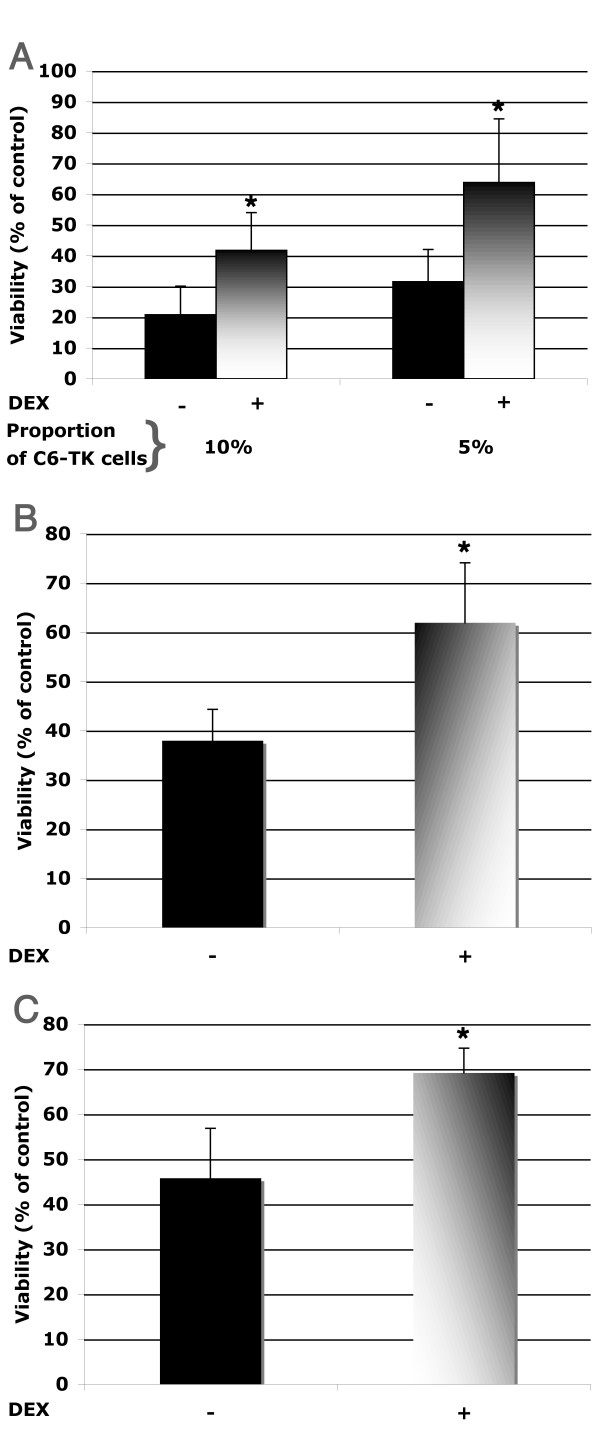
Effect of dexamethasone on the bystander effect. (A) The viability of C6 cells mixed with 10 % (left) or 5 % (right) of C6-TK cells and treated with ganciclovir (2 μM) for 5 days is shown in the presence (+) or absence (-) of dexamethasone (1 μM, DEX). (B) Viability of LN18 cells mixed with 20 % LN18-TK cells and grown for 5 days with ganciclovir (10 μM) in the presence (+) or absence (-) of DEX. (C) Viability of U87 cells mixed with 10 % U87-TK cells and grown for 5 days with ganciclovir (10 μM) in the presence (+) or absence (-) of DEX. For each condition, the viability in the absence of ganciclovir was set as 100 percents. (*: P < 0.05, Student's t-test)